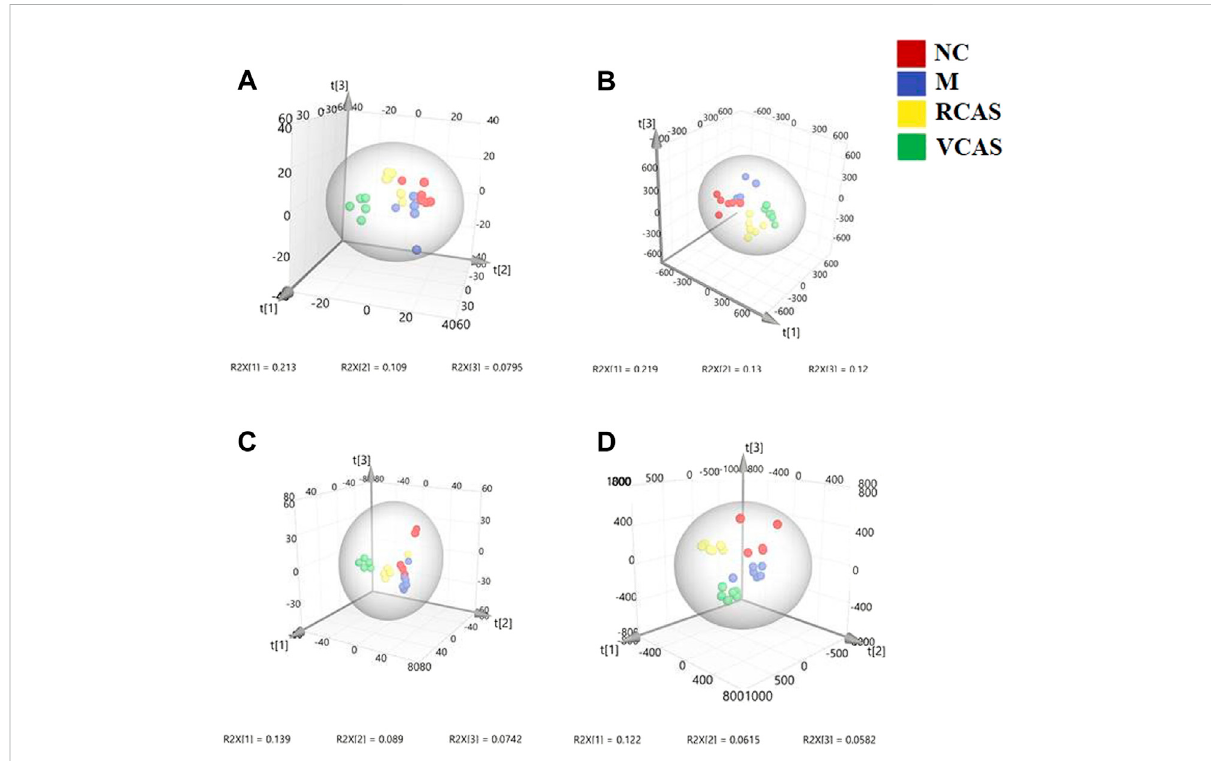
FIGURE 3 PCA and PLS-DA 3D-score scatter plot ofUPLC-Q-TOF/MS data from plasma samples. (A) PCA 3D-score scatter plot in thepositive ion mode; (B) PCA3D-score scatterplotinthenegativeionmode; (C) PLS-DA3D-scorescatterplotinthepositiveionmode; (D) PLS-DA3D-scorescatterplot in negative ion